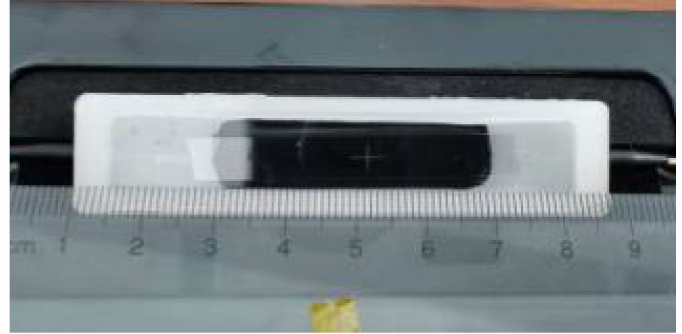
Figure 7. Photograph of the packaged